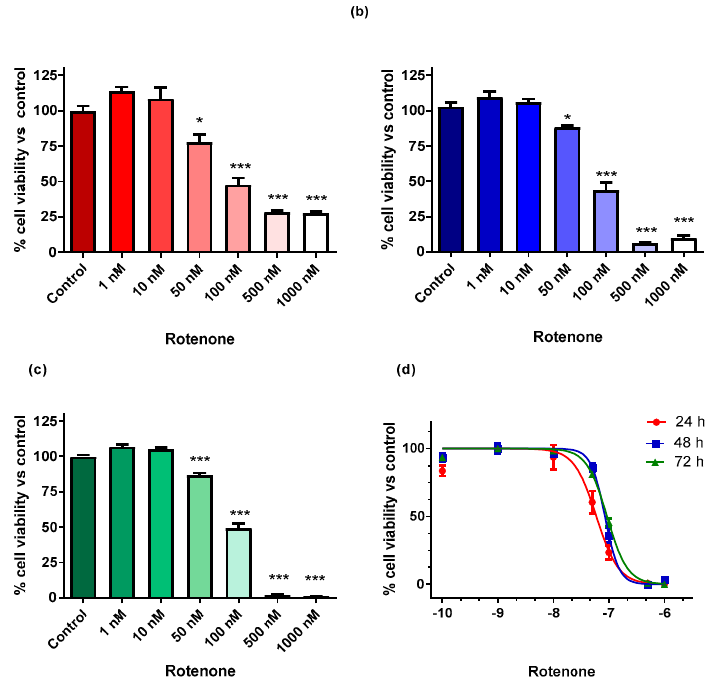
Figure 1. Viability of BV-2 cells exposed to different rotenone concentrations (1–1000 nM) at progressively longer time intervals: ( a ) 24 h, ( b ) 48 h and ( c ) 72 h. ( d ) Rotenone toxicity curves for BV-2 cell viability over time. The data represent the average ± SEM of 3 independent experiments ( n = 6). * p < 0.05 and *** p < 0.0001 vs control, according to one-way analysis of variance (ANOVA) followed by Bonferroni post hoc test for multiple comparisons.